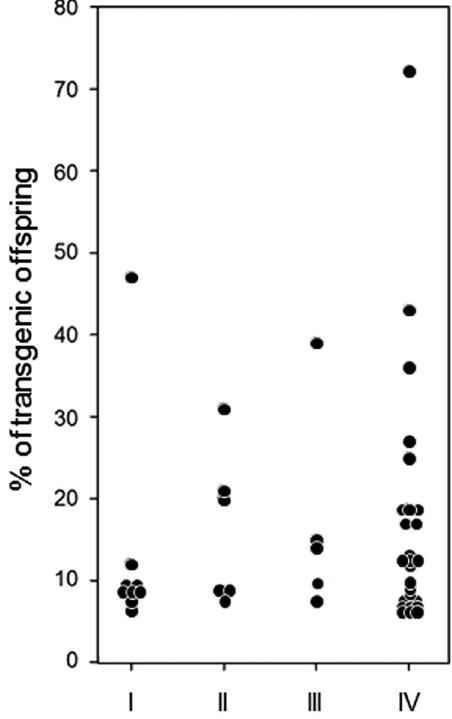
Figure 3. The relative proportion of offspring possessing the transgene for each of the transgenic detected queens. Because in some queens more than 16 individuals were analysed, we standardized for the expected number, if only 16 samples would have been examined. The conditions were as follows: (I) iPBase, 90 pg, posterior, tested queens N = 47. (II) hyPBase apis , 90 pg, posterior, tested queens N = 27. (III) hyPBase apis , 240 pg, posterior, tested queens N = 16. (IV) hyPBase apis , 240 pg, anterior, tested queens N =